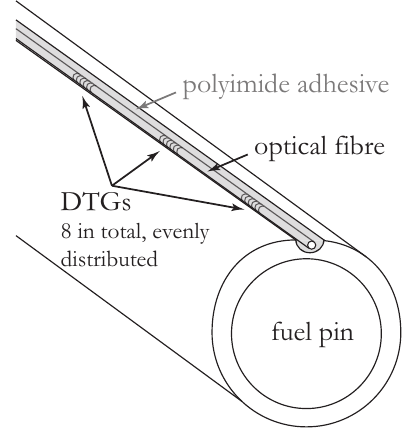
Figure 3. Scheme of an optical fiber with draw tower gratings (DTGs) embedded in a small groove near the surface of the